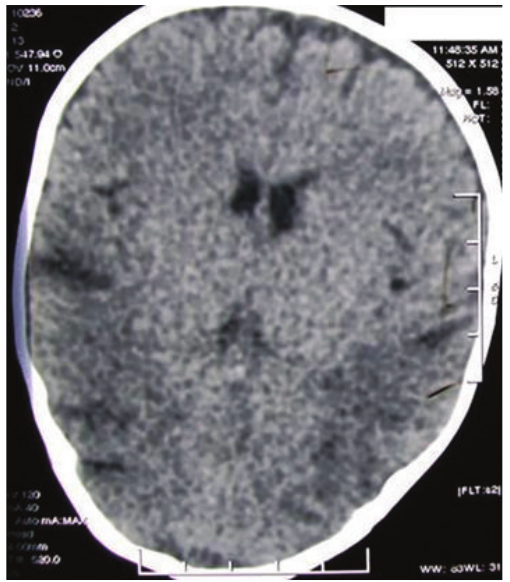
Figure 2: Axial computerized tomography scan shows hypodensi- ties in bilateral posterior parietal subcortical white matter.